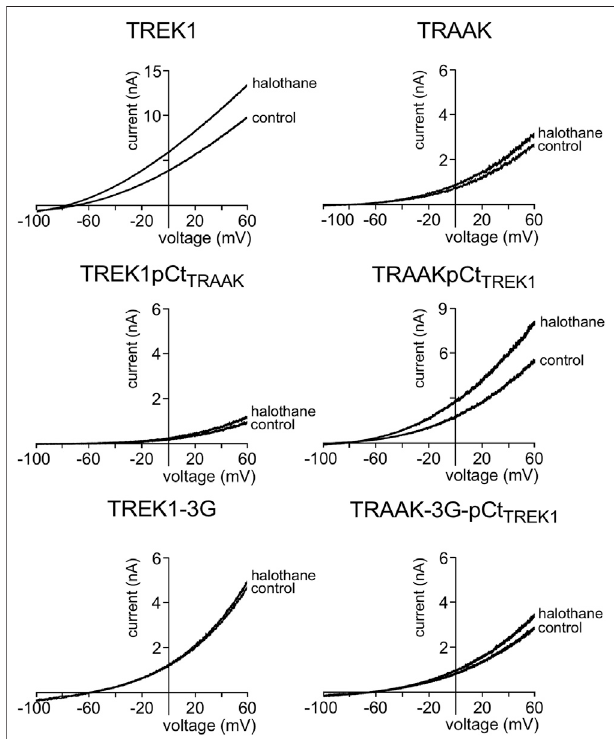
FIGURE4| ProximalC-terdomain(pCt)modulateschannelsensitivityto drugs. Representative patch-clamp recordings from HEK cells expressing the indicated channels in the presence of halothane (1 mM). Voltage ramps were applied from − 100 to 60 mV from a holding potential of − 80mV.